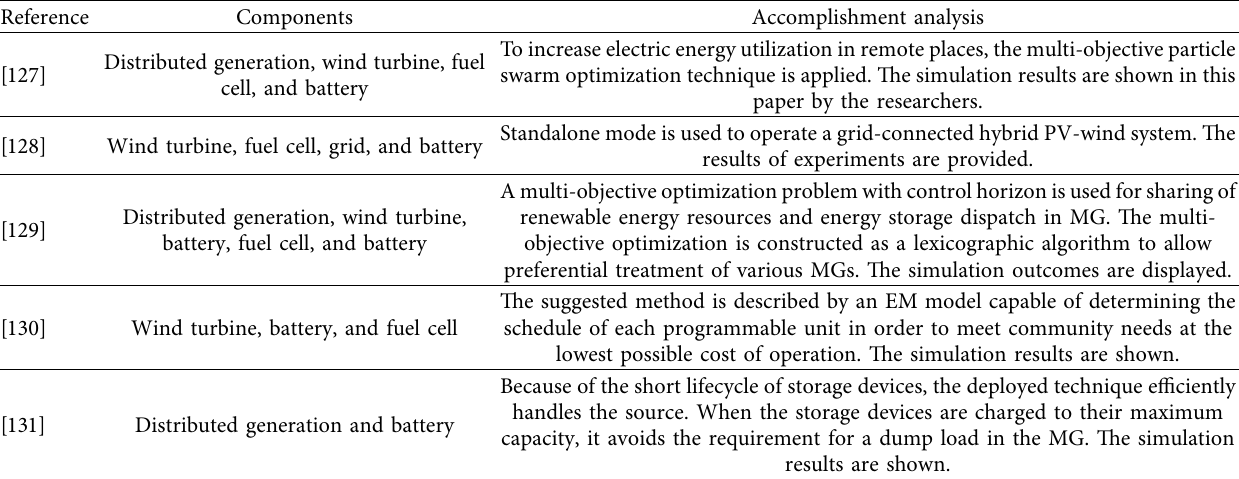
Table 5: Recent literature survey on hybrid system